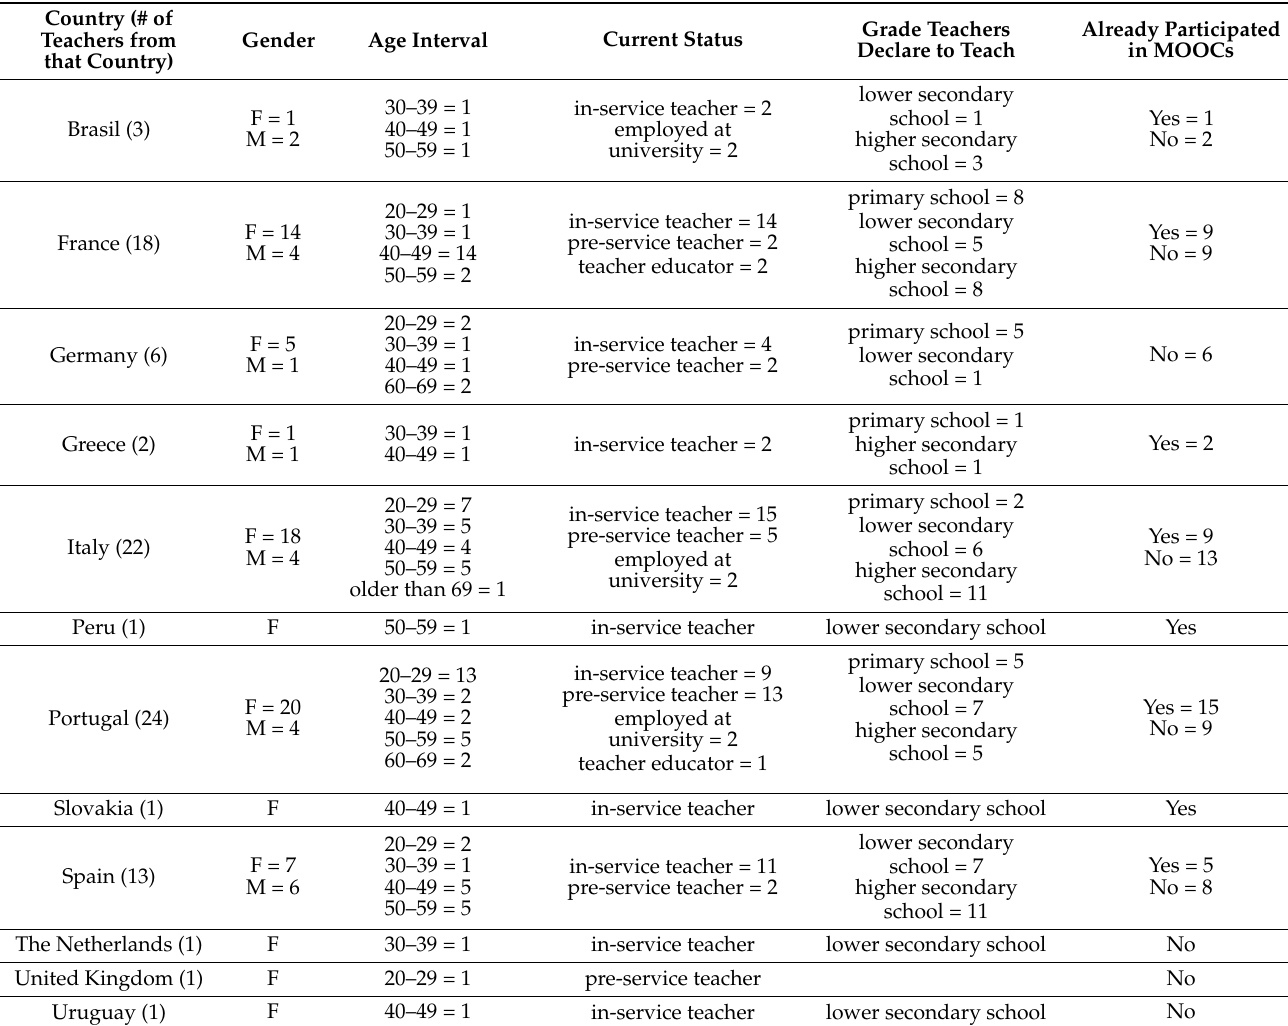
Table 1. Detailed information about the 93 MOOC